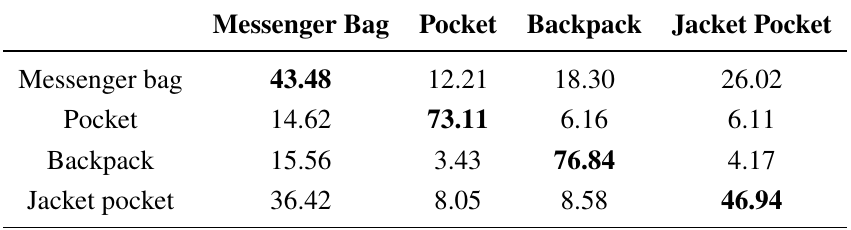
Table 2. Confusion matrices with motion-related features, Dataset 1 (random